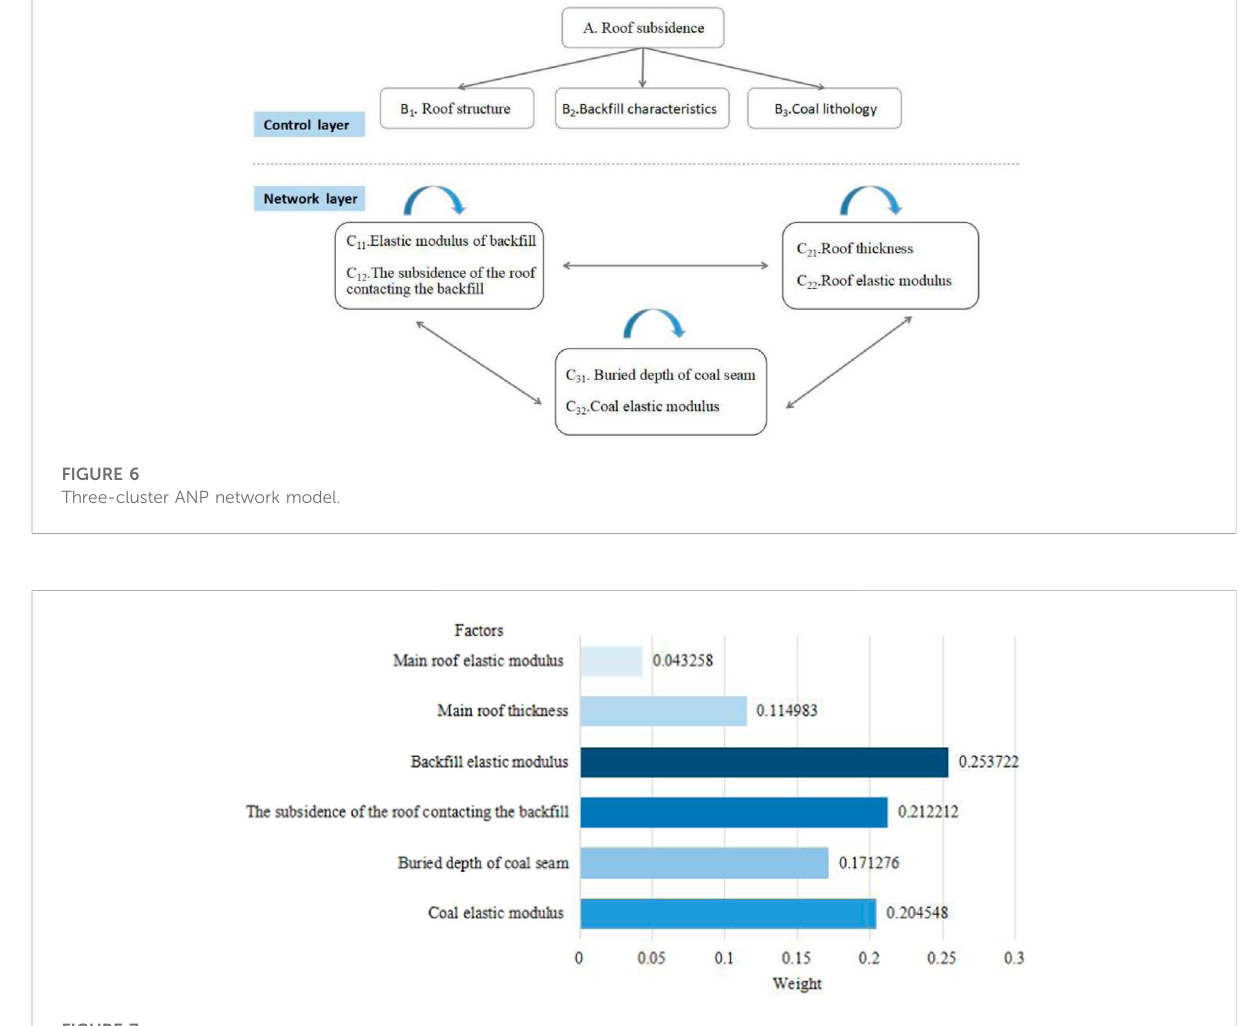
FIGURE 7 Distribution diagram of the weights for the main roof subsidence factors.